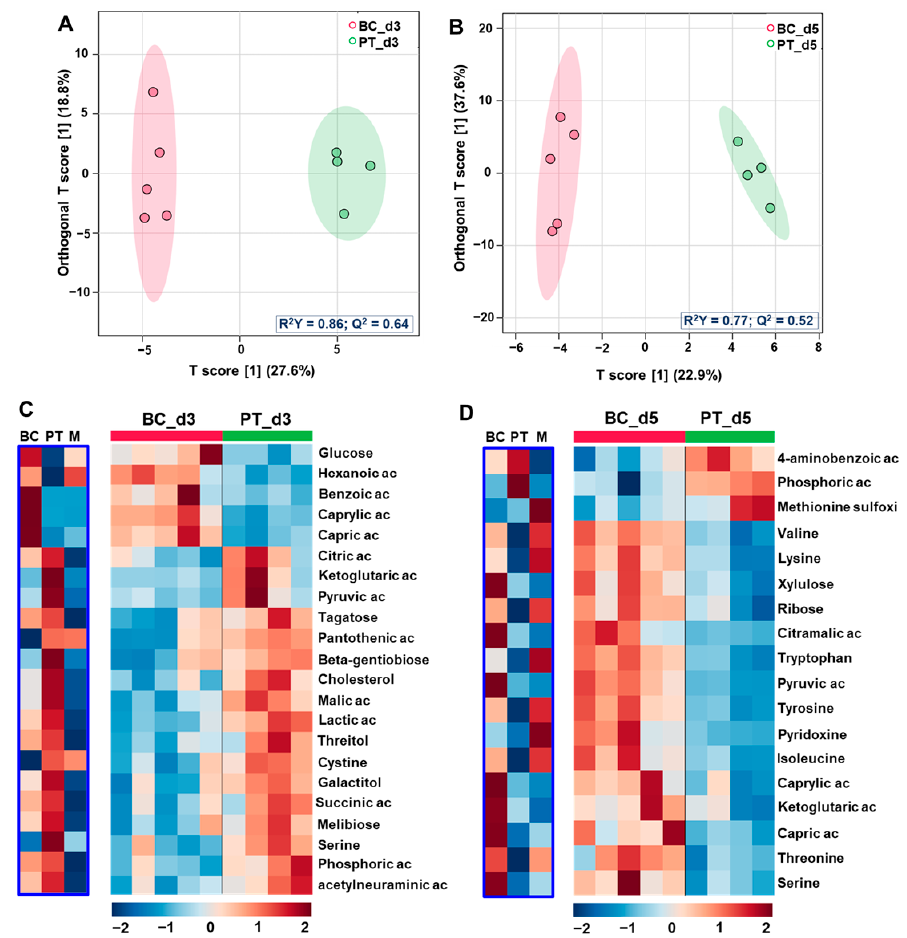
Figure 4. Comparison of metabolomic profiles of biochip and Petri cultures at different time points. ( A , B ) OPLS-DA score plots of Petri and biochip cultures comparisons on Day 3 (BC_d3 vs. PT_d3) and Day 5 (BC_d5 vs. PT_d5), respectively; ( C , D ) heatmap of metabolites significantly modulated in BC_d3 vs. PT_d3 and BC_d5 vs. PT_d5 comparisons, respectively. The blue box represents the levels of metabolites in Petri (PT) and biochip (BC) compared to the initial culture medium (M). OPLS-DA: orthogonal projections to latent structures-discriminant analysis; BC_d3 and BC_d5: biochip cultures after 3 and 5 days; PT_d3 and PT_d5: Petri cultures after 3 and 5 days.